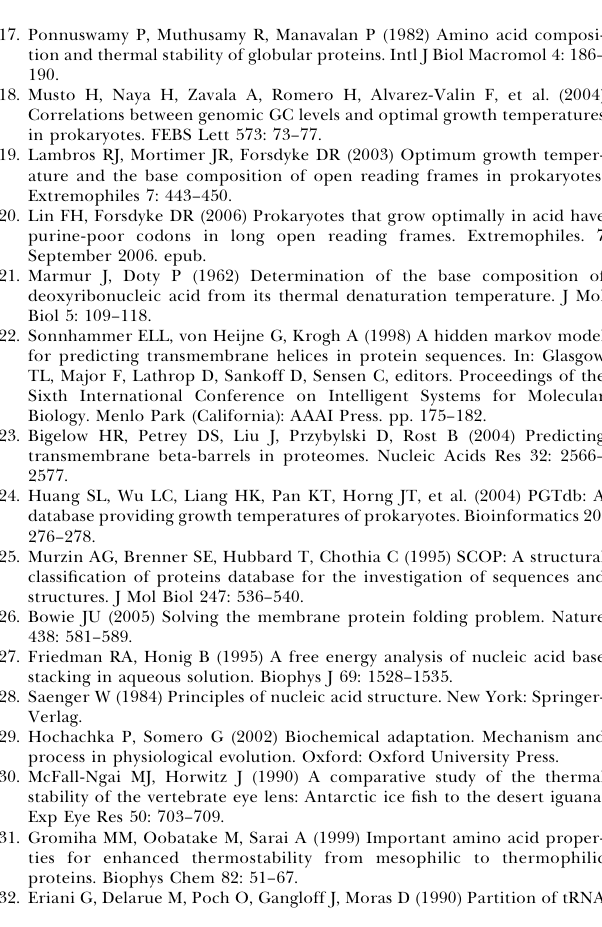
Figure S1. Dependence of the Fraction of KVYWREP Amino Acids on the OGT for the 204 Genomes from Table S1 Found at doi:10.1371/journal.pcbi.0030005.sg001 (134 KB DOC). Figure S2. Histogram of the Values of the Correlation Coefficient R between OGT and Fraction F of a Set of Amino Acids for All Possible Seven-Letter Combinations and IVYWREL Combinations with One Substitution Found at doi:10.1371/journal.pcbi.0030005.sg002 (132 KB DOC). Figure S3. Probability to Find Each of the 20 Amino Acids in the Predictor Combinations (Highest- R Amino Acid Combination) Calculated from 1,000 of 43-Organism Training Sets Found at doi:10.1371/journal.pcbi.0030005.sg003 (126 KB DOC). Figure S4. Dependence of the Fraction of G þ C Nucleotides on the OGT for the 204 Genomes from Table S1 Found at doi:10.1371/journal.pcbi.0030005.sg004 (147 KB DOC). Table S1. Cardinal Temperatures of Prokaryotes (Minimum, Optimal, and Maximum Growth Temperatures) Found at doi:10.1371/journal.pcbi.0030005.st001 (477 KB DOC). Table S2. Combinations of Amino Acids Giving the Ten Highest Values of the Correlation Coefficient R between OGT and Fraction of the Amino Acids for 86 Proteomes Found at doi:10.1371/journal.pcbi.0030005.st002 (29 KB DOC).